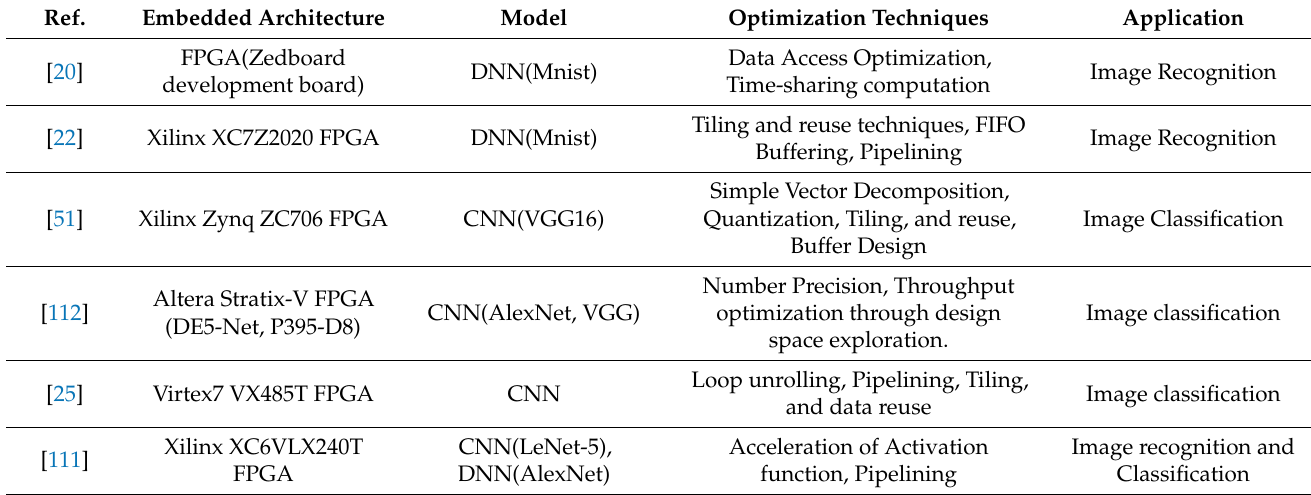
Table 11. Some DNN Optimization